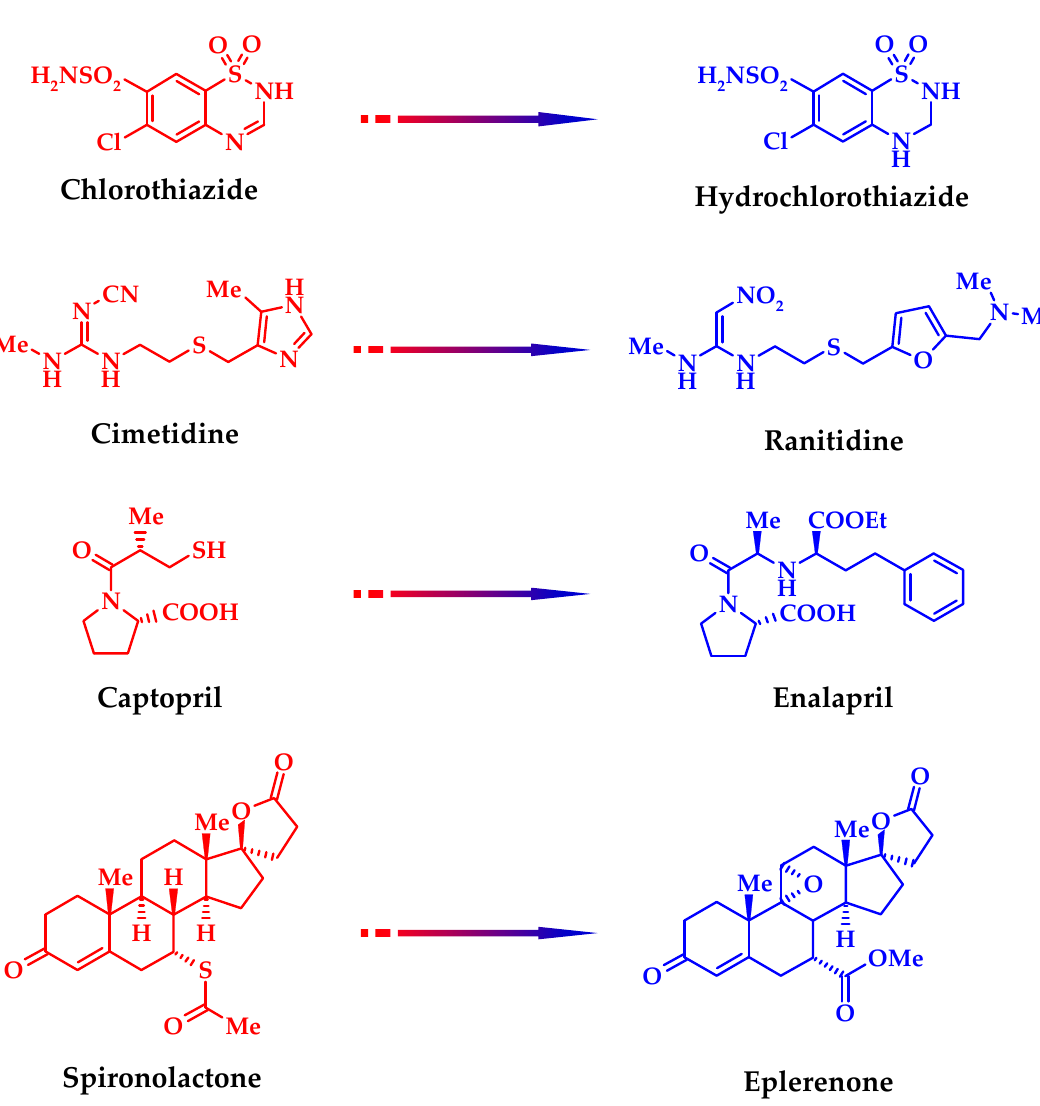
Figure 1. Improved “copies” of the known drugs created by the “me-too” technique [1–5].